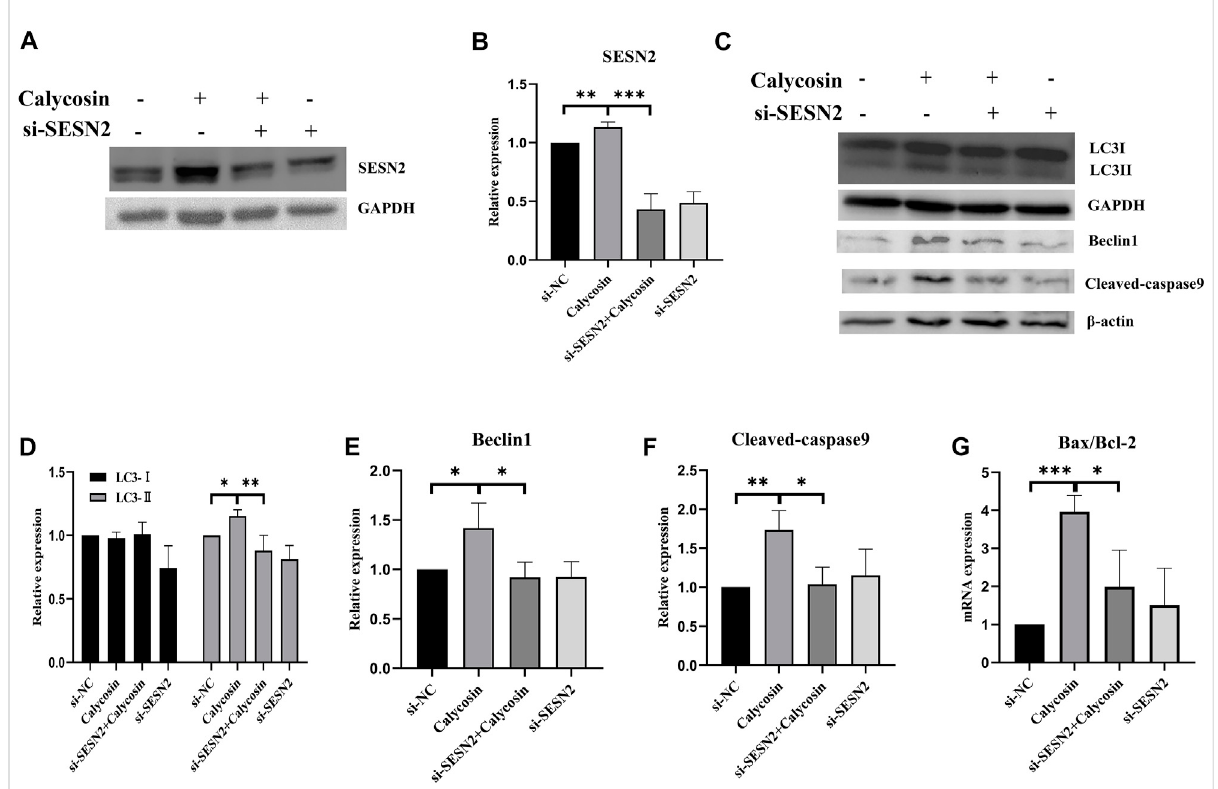
FIGURE 6 Calycosin inducedapoptosis of B-CPAP cell and promotedautophagyrelated to SESN2. (A,B) The expressionof SESN2 protein inB-CPAP cells treated with si-NC, si-SESN2 and/or calycosin (100 µM). (C – F) LC3 Ⅰ / Ⅱ , Beclin1, Cleaved-caspase 9 proteins expression in B-CPAP cells treated with si-NC,si-SESN2and/orcalycosin(100 µM). (G) qRT-PCRanalysisshowingrelativelevelsofBax/Bcl-2transcriptsinsi-NC,si-SESN2and/orcalycosin (100 µM)-treated B-CPAP cells. Results are representative of three independent experiments. * p < 0.05, ** p < 0.01,*** p <